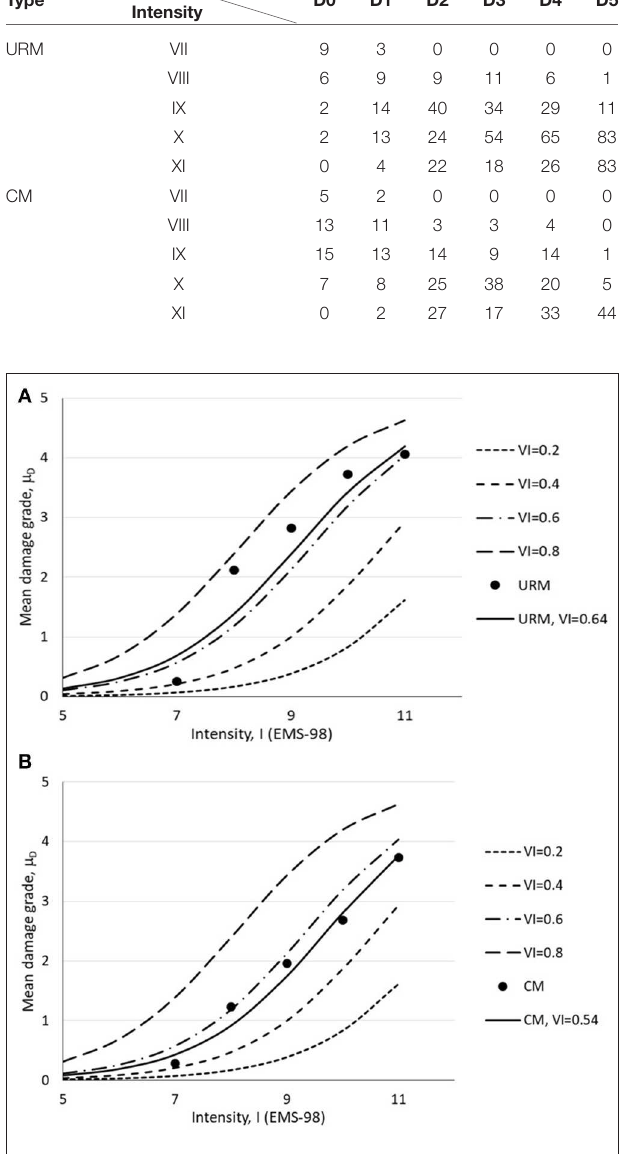
FIGURE 9 | Mean damage grade as a function of intensity from damage survey detected for (A) URM buildings and (B) CM buildings under Sarpol-e-zahab and Bam earthquakes